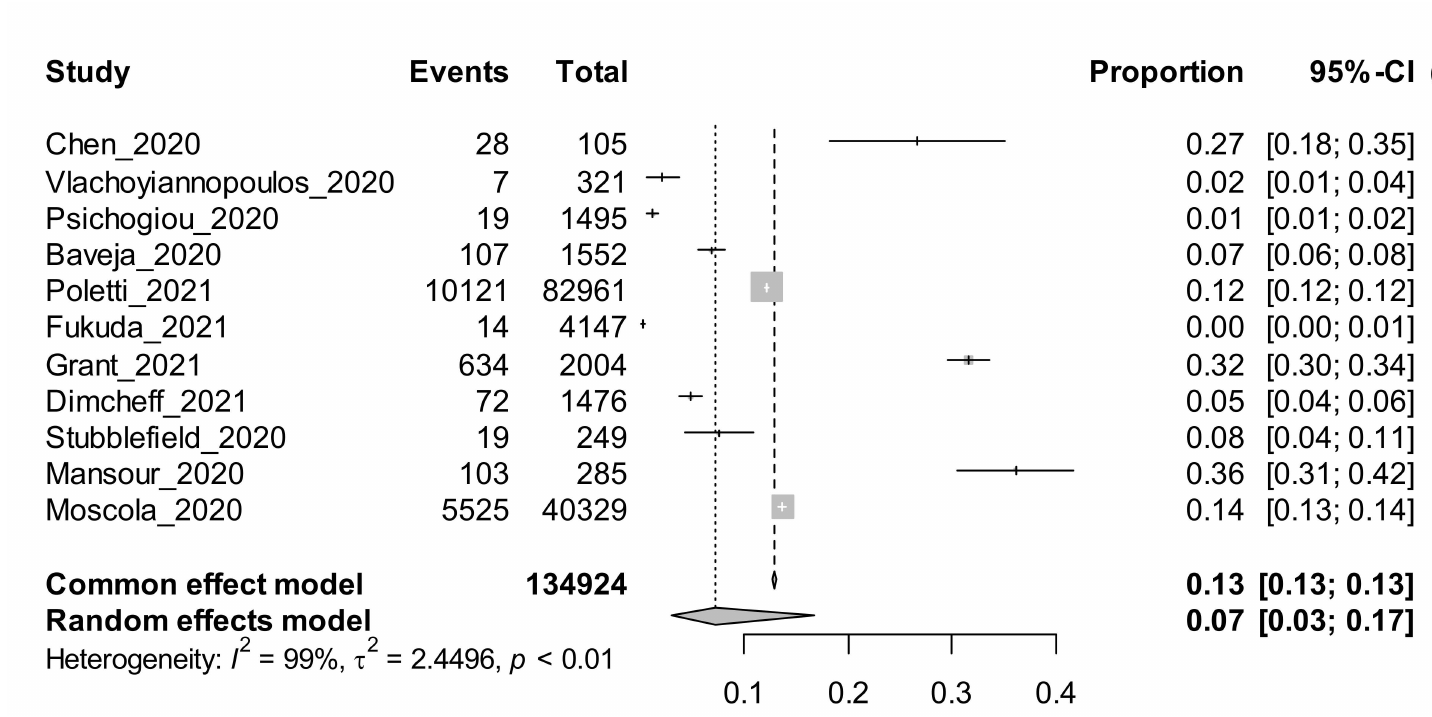
Figure 1. Forest plot showing the prevalence of COVID-19 among studies using the antibody method of